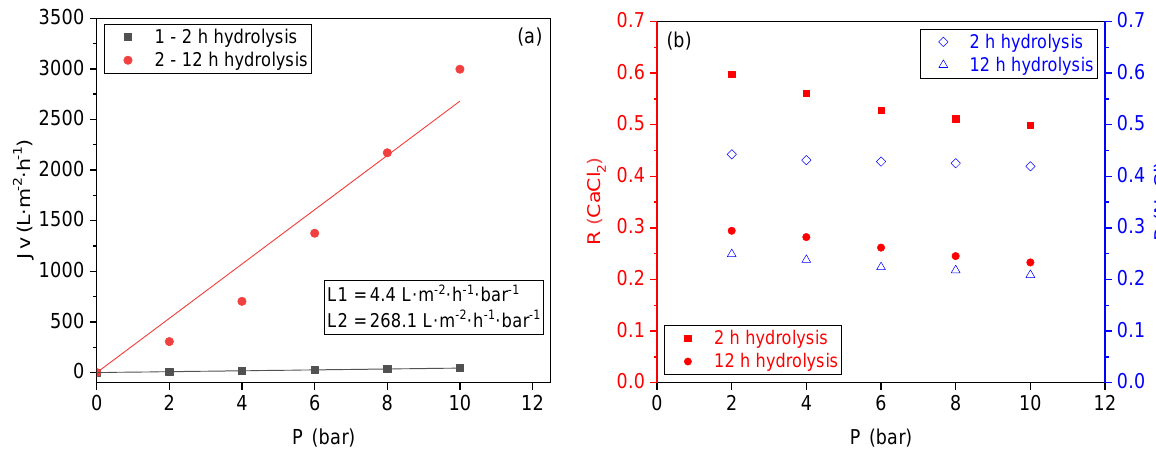
Figure 7. Plots of the flux ( a ) and 0.2% CaCl 2 and 0.2% NaCl salts rejection ( b ) against pressure for membranes obtained at different hydrolysis times.